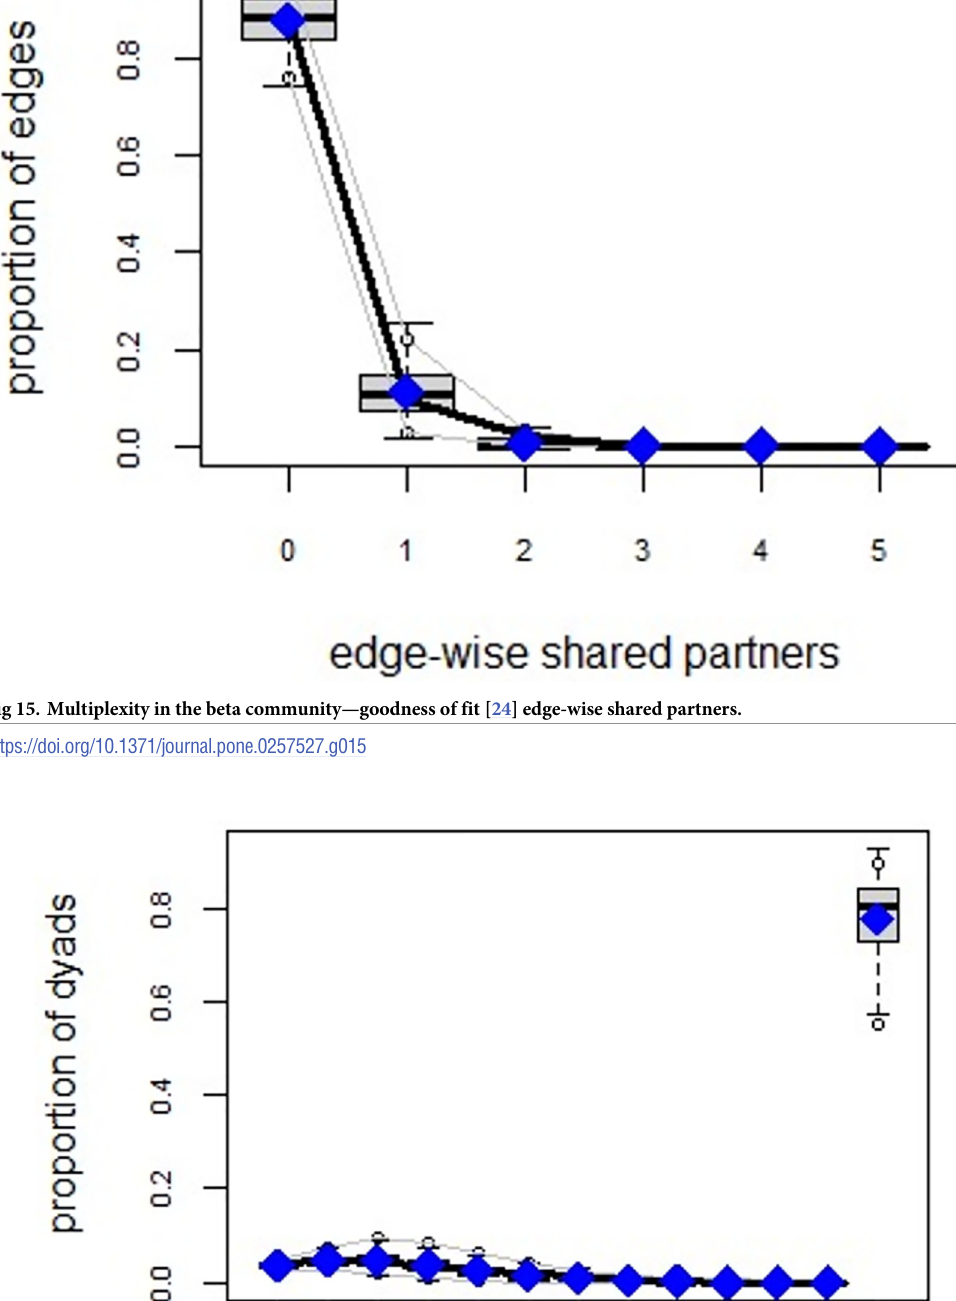
PLOS ONE | https://doi.org/10.1371/journal.pone.0257527 September 27,